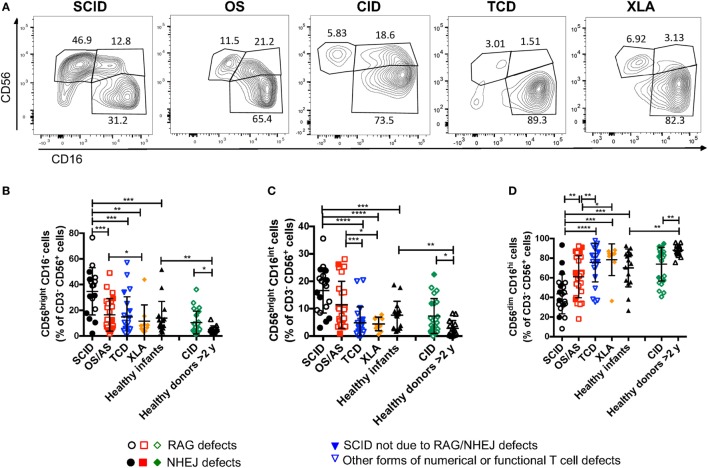
Flow cytometry analysis of CD56 and CD16 expression in natural killer cells from patients and controls. (A) Representative analysis of the expression of CD56 and CD16 in CD3− CD19− CD14− CD56+ cells from one patient each belonging to the severe combined immune deficiency (SCID), Omenn syndrome (OS), delayed-onset combined immune deficiency (CID), other forms of T cell defect (TCD), and X-linked agammaglobulinemia (XLA), respectively. (B–D) Percentage of CD56bright CD16−
(B), CD56bright CD16int
(C), and CD56dim CD16hi
(D) cells among CD3− CD19− CD14− CD56+ cells. For each marker, positivity was defined as fluorescence intensity above that of isotype control. Bars represent mean ± SD values. *p < 0.05; **p < 0.01; ***p < 0.005; ****p < 0.001.